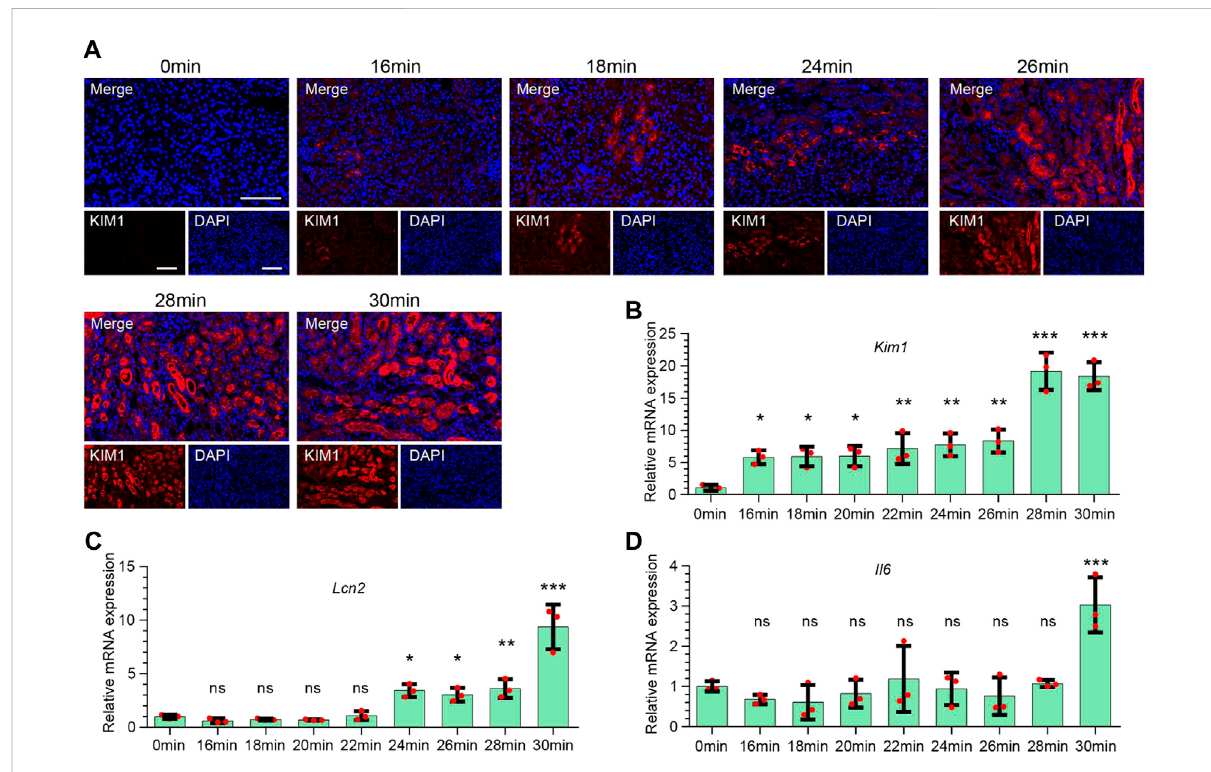
FIGURE 2 Expression characteristics of injury-related molecules of kidney injury at different ischemia time points. (A) Representative immuno fl uorescencestainingofKIM1expressioninrenaltissuesatdifferentischemiatimepoints.RedstandsforKIM1.Scalebars:100 μ m (B – D) The mRNA expression of Kim1 (B) , Lcn2 (C) , and Il6 (D) in renal tissues at different ischemia time points. One-way ANOVA and Dunnett-t test, n = 3 per group, ns indicates no signi fi cant, * p < 0.05, ** p < 0.01, *** p < 0.001, compared to 0min